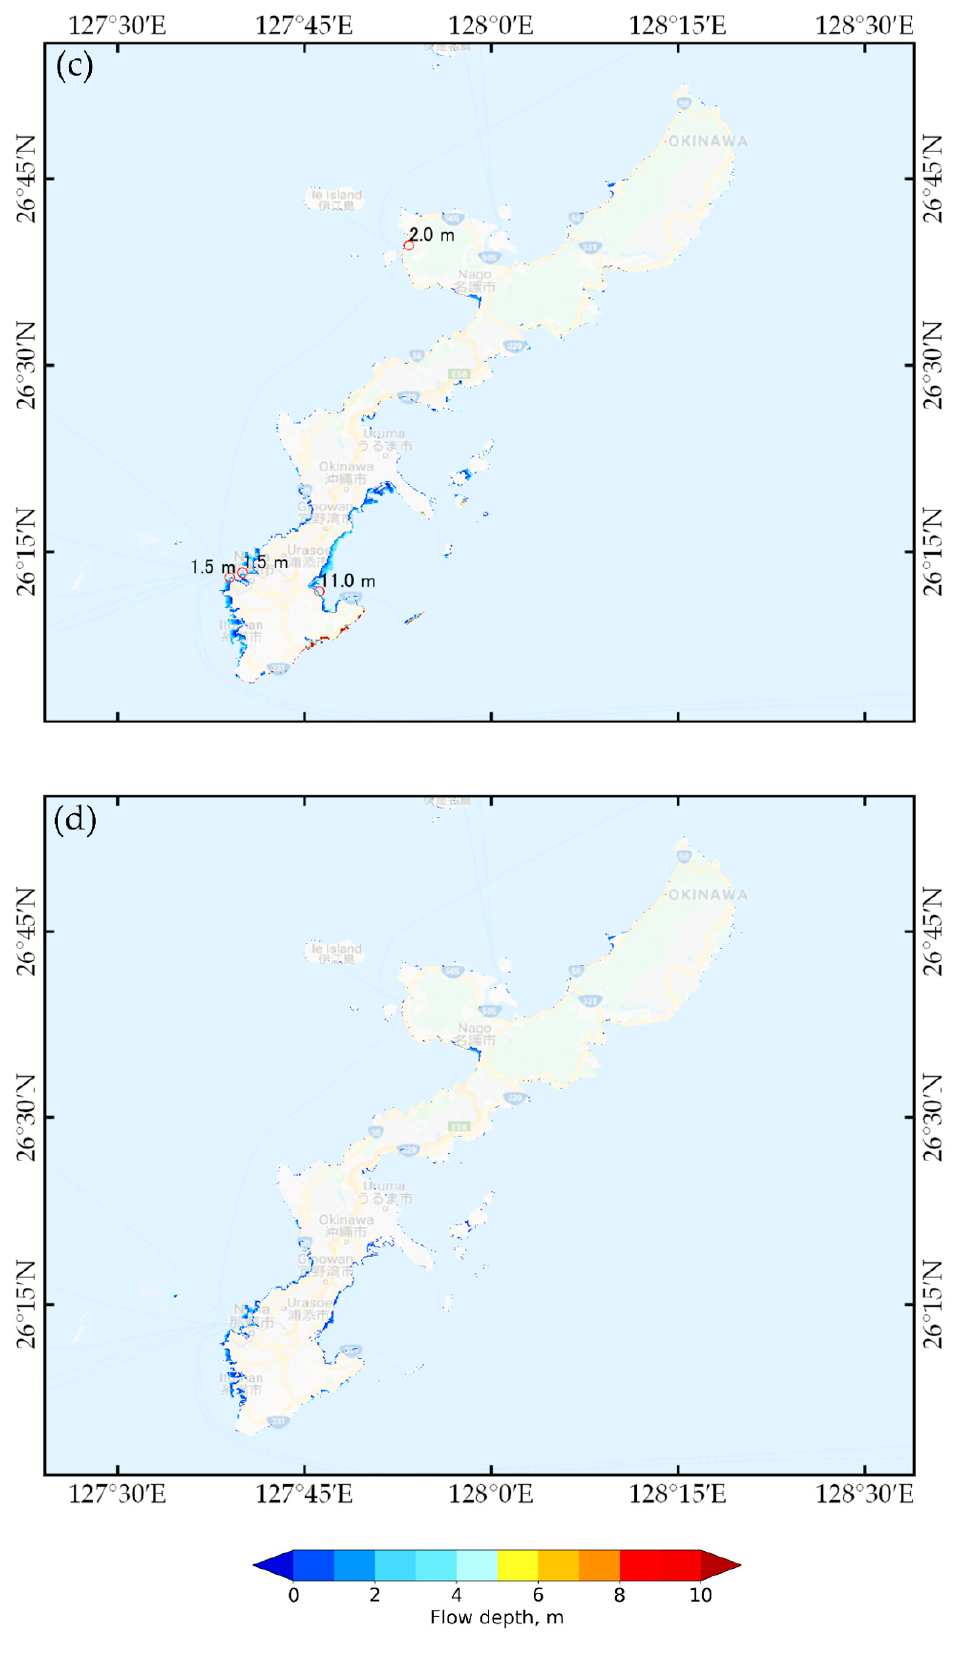
Figure 8. Maximum flow depth generated by the fault parameters of the earthquake scenario. ( a )